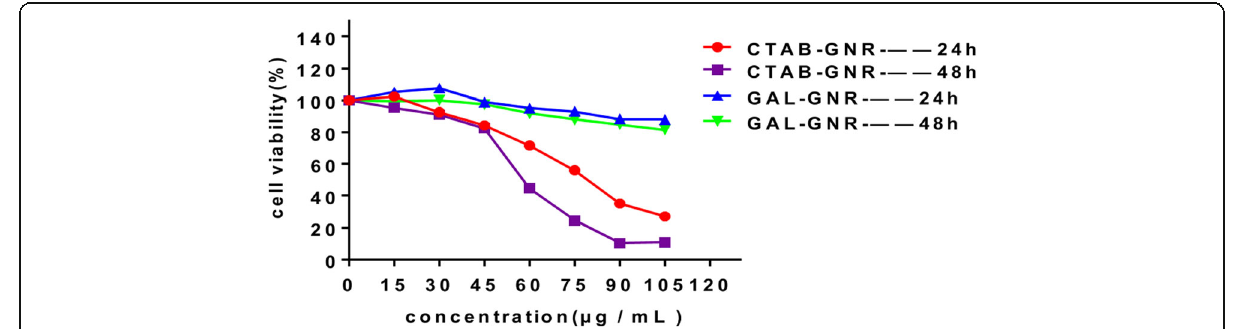
Fig. 3 Toxicity of GAL-GNR. Hepa1-6 cells were treated with GNR (CTAB-GNR) or GAL-GNR for 24 or 48 h at the indicated concentrations. Cell viability was measured by MTT assay ( n =